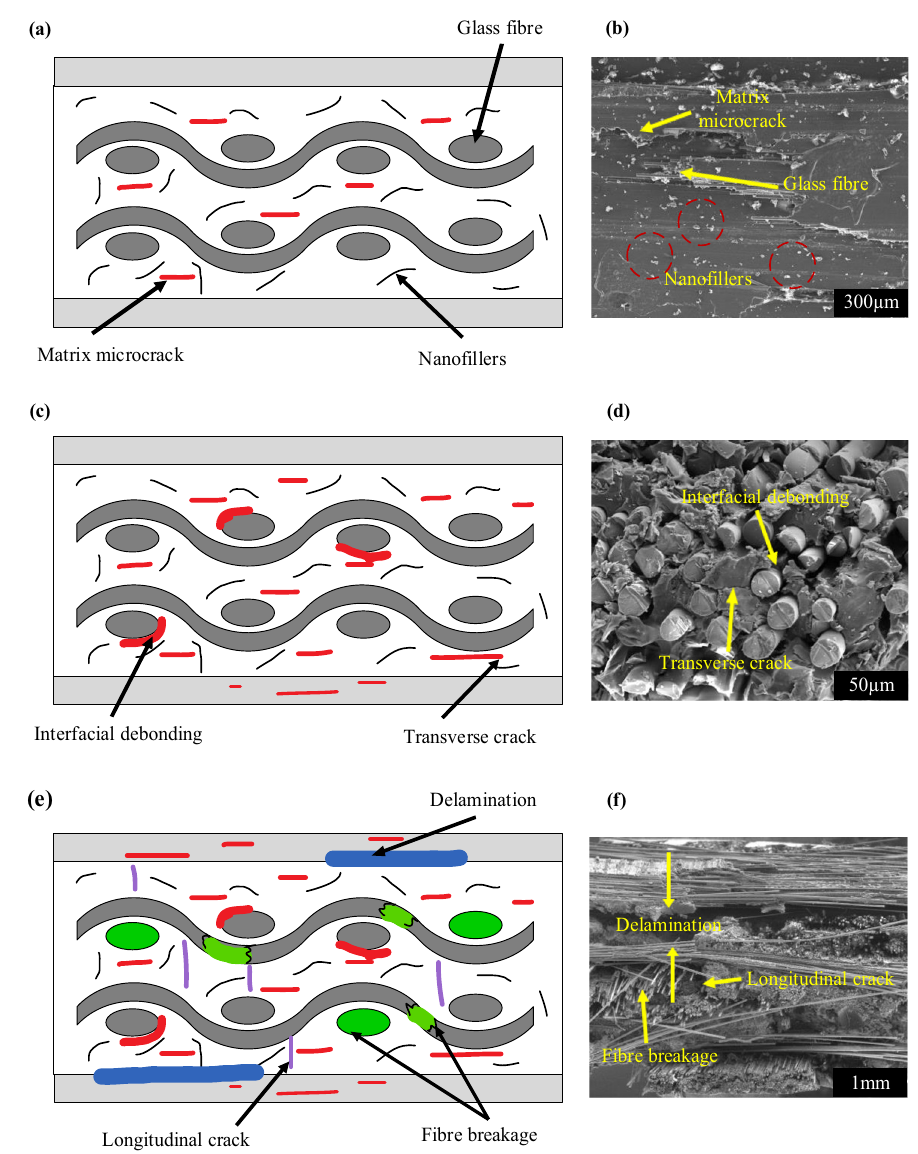
Figure 5: Damage illustration and FESEM images for GNP - glass and MWCNT - glass composites: ( a ) and ( b ) matrix microcrack, ( c ) and ( d ) interfacial bonding and transverse crack, and ( e ) and ( f ) delamination, fi bre breakage, and longitudinal